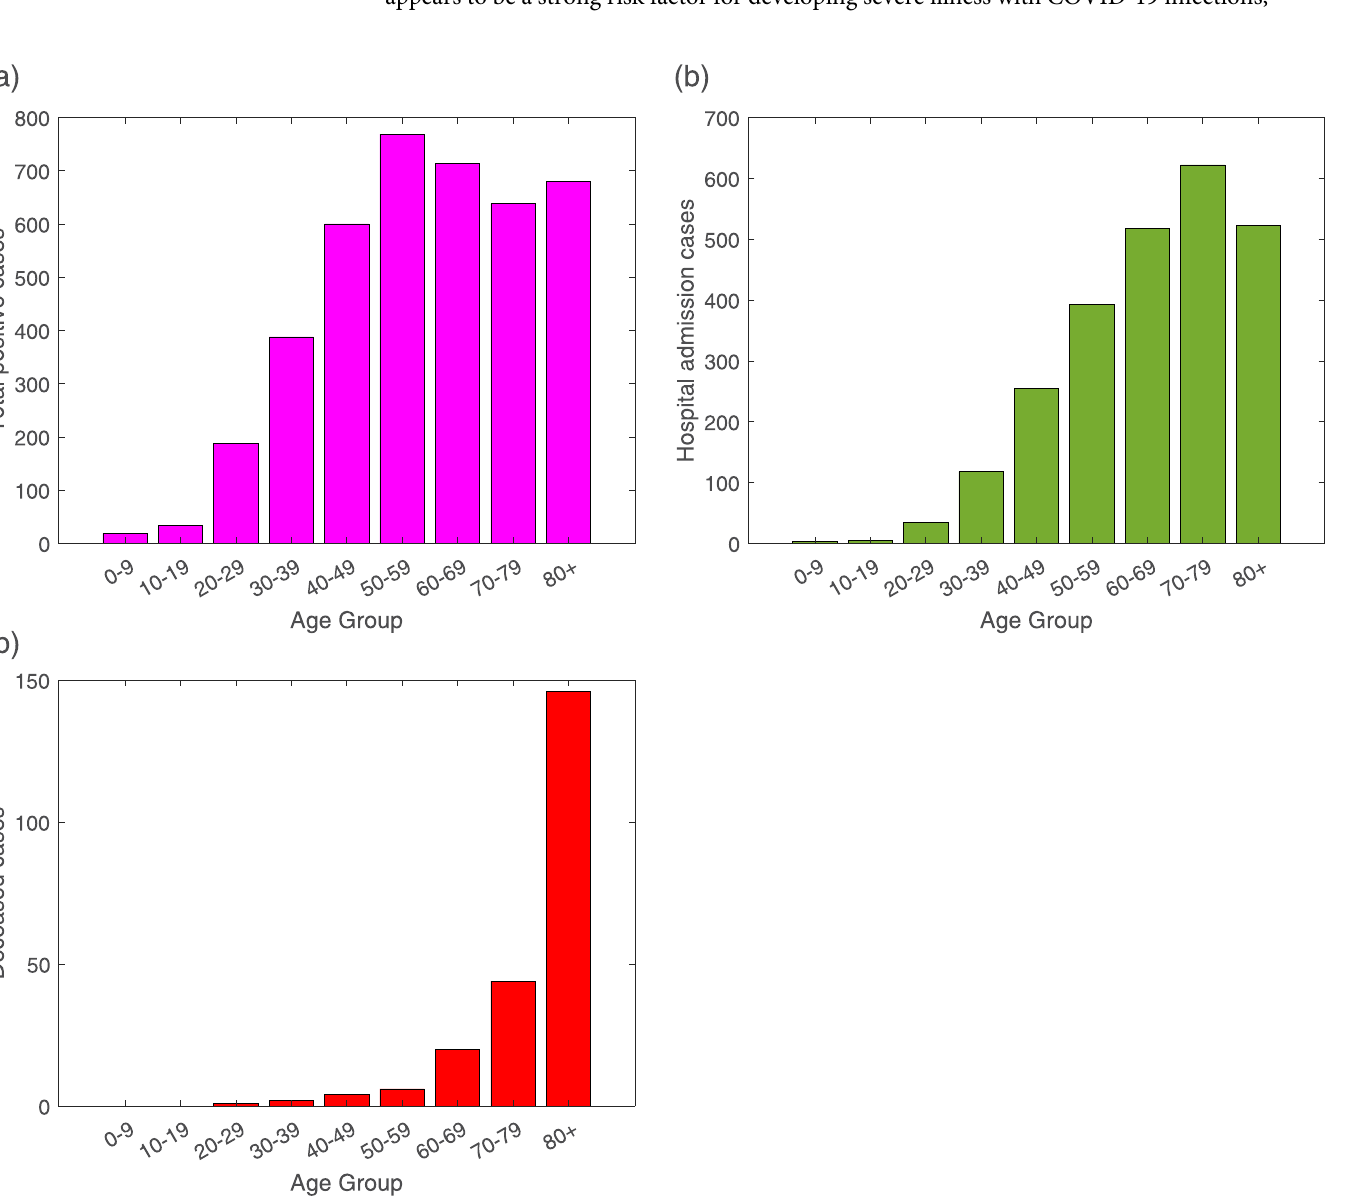
PLOS ONE | https://doi.org/10.1371/journal.pone.0267772 July 13,